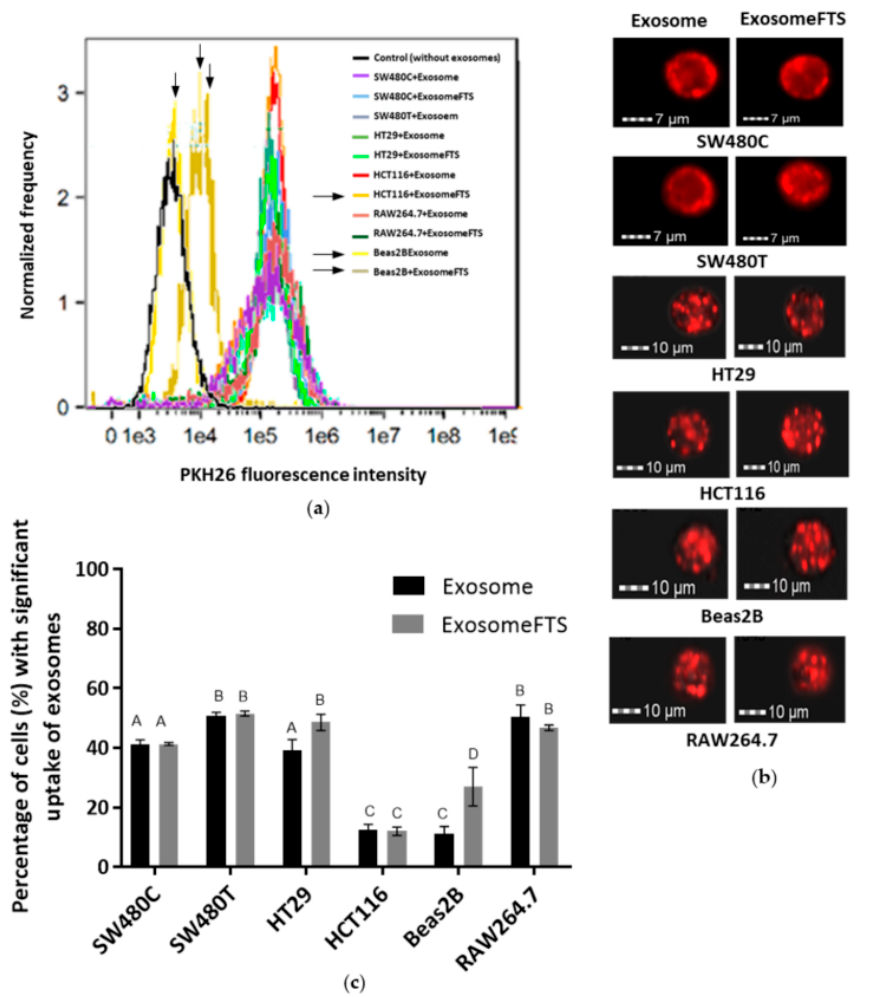
Figure 6. Imaging flow cytometry analysis of various cell types with uptake of exosomes derived from SW480 cells after 24 h of incubation (SW480C—Control cells; SW480T—FTS-treated cells). ( a ) The flow cytometry graphs show red fluorescence intensities detected in various cell types that received PKH26-stained exosomes; ( b ) Representative images of recipient cells captured using Amnis ImageStream X Mark II; ( c ) Percentage of cell uptake with significant quantities of PKH26-stained exosomes based on the spot count analysis using IDEAS software. Means with different letters indicate a significant difference between groups ( n = 3, p < 0.05; one-way ANOVA-Tukey’s multiple comparison tests).